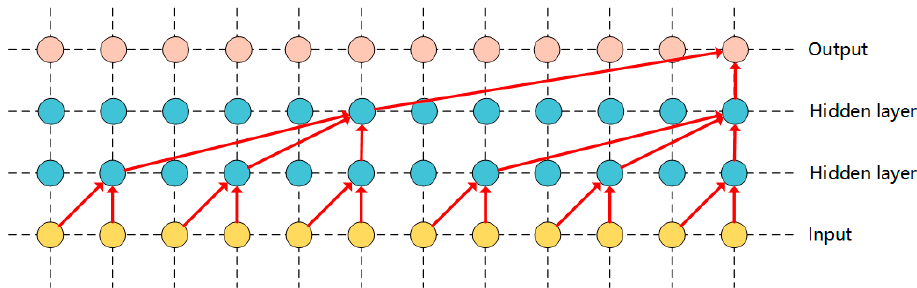
Figure 4. Causal Convolution Model Structure. Figure 5. Causal Holes Convolution model structure. Figure 5. Causal Holes Convolution model